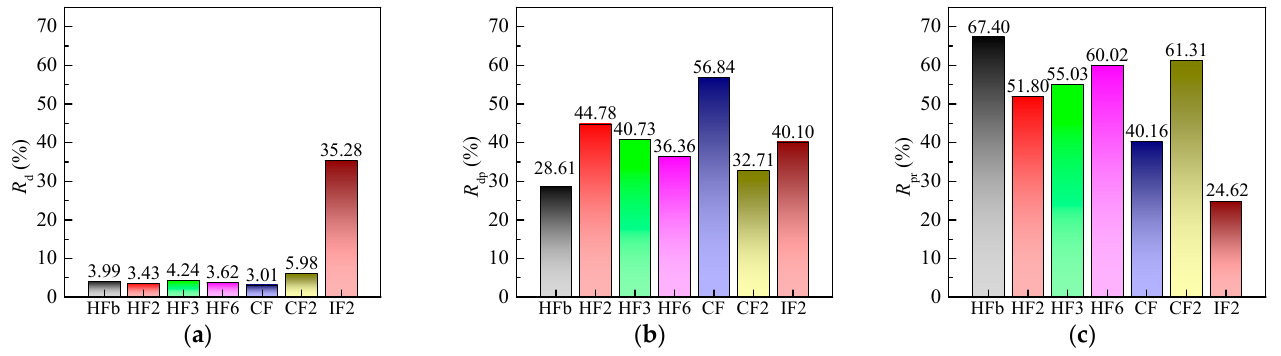
Figure 14. The energy ratios of different deformed steel fibers: ( a ) R d ; ( b ) R dp ; ( c ) R pr .